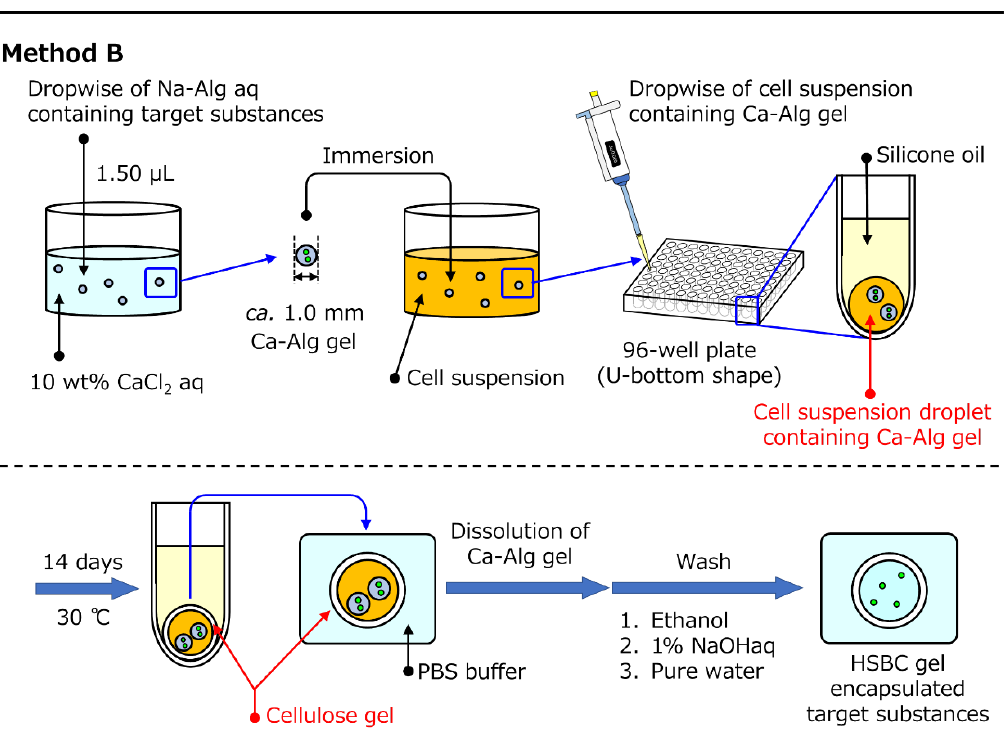
Figure 1. Schematic representation of methods for the production of the hollow-type spherical bacterial cellulose (HSBC) gel encapsulating millimeter- and micrometer-sized particles. (Method A) HSBC gel encapsulating millimeter-sized particles. (Method B) HSBC gel encapsulating micrometer-sized particles.